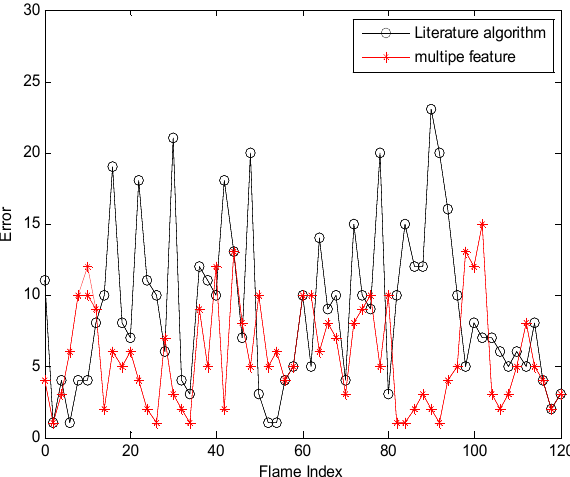
Figure 15. The RMSE comparison corresponding to background changes.